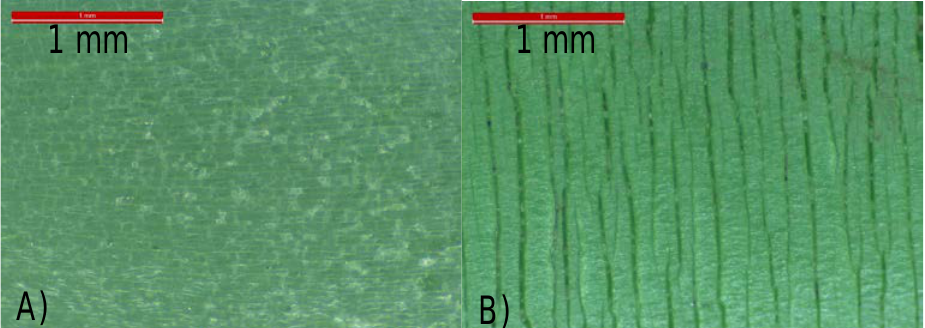
Figure 7. Optical micrographs for pipe P061 after aging test to internal hydrostatic pressure (P061aged): ( A ) inner part in contact with pressure and hot water; and ( B ) outer section in contact with warm dry air.